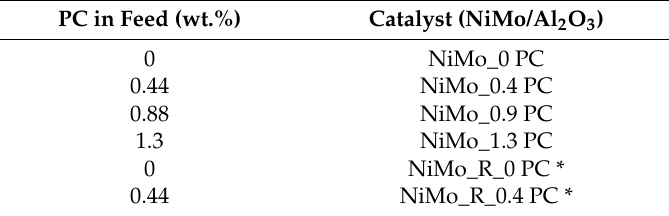
Table 5. Concentration of phospholipid studied and acronyms used in this article. PC in Feed